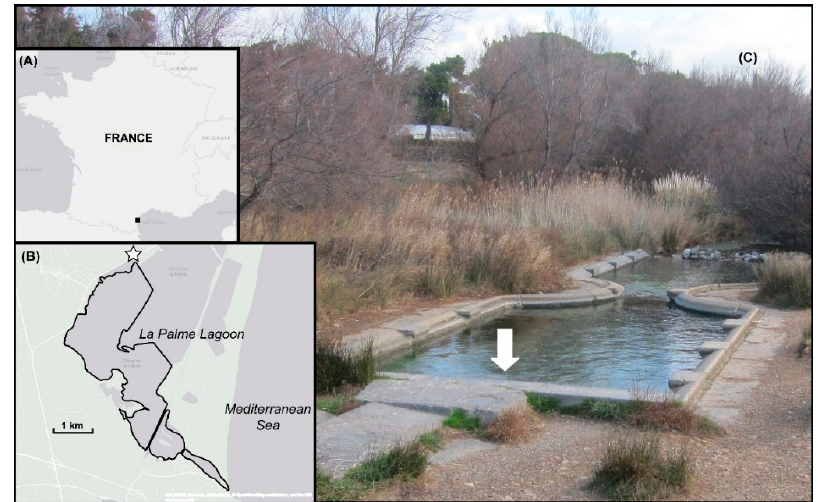
Figure 1. ( A ) Location of La Palme lagoon, in France, ( B ) location of the karstic groundwater spring located at the white star (Lavoir: no longer used wash-basin), and ( C ) Picture of the spring basin. The white arrow indicates the outlet of the spring.